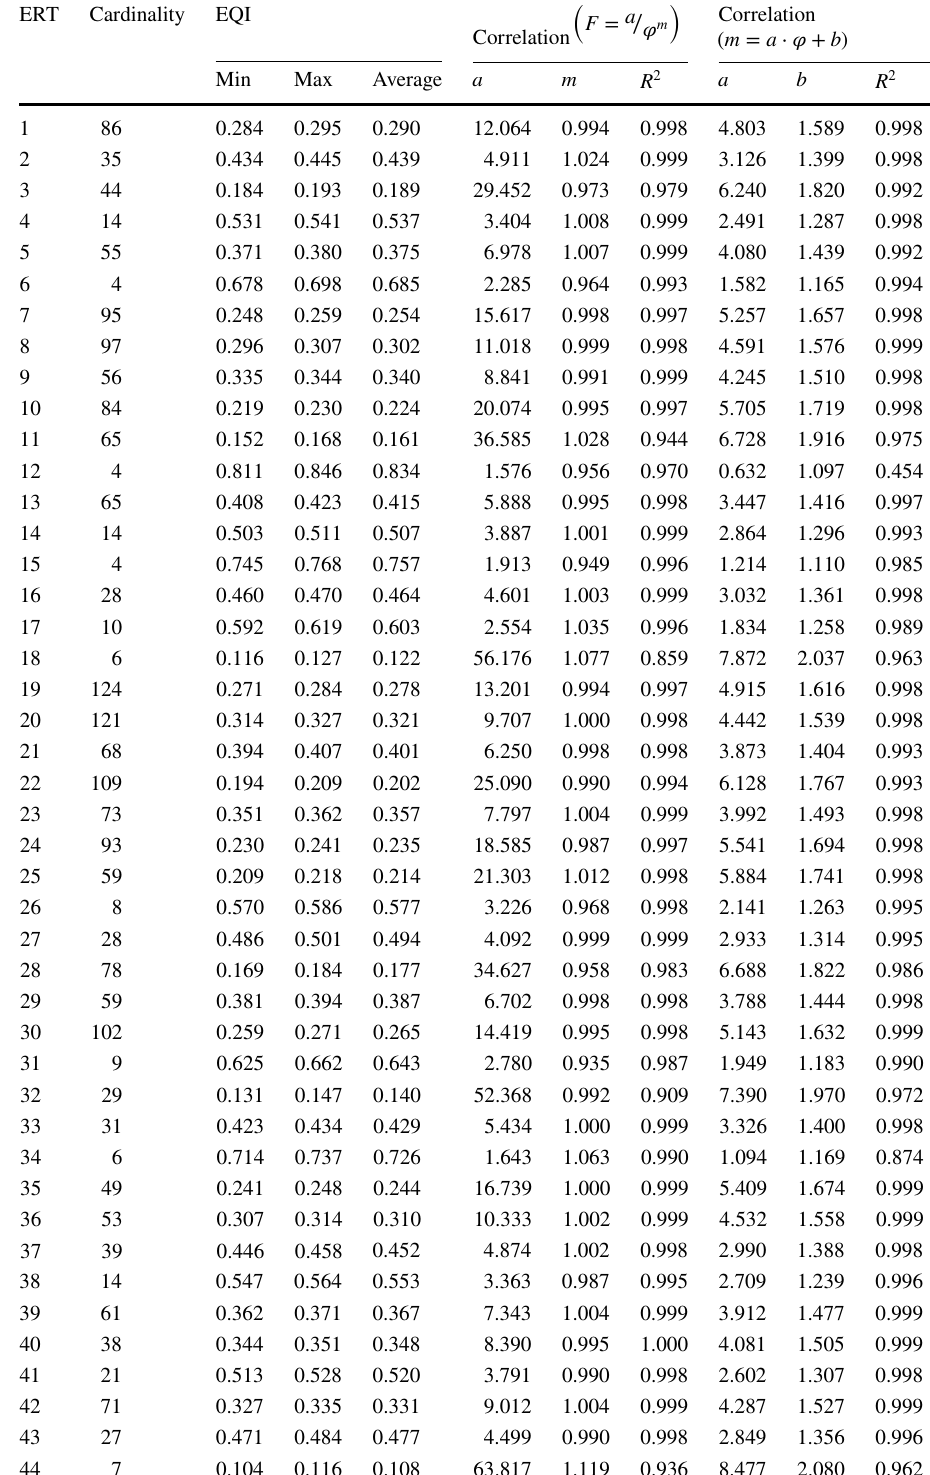
Table 5 Results of EQI technique for 44 ERTs generated by EQI-GMM model on training data from carbonate